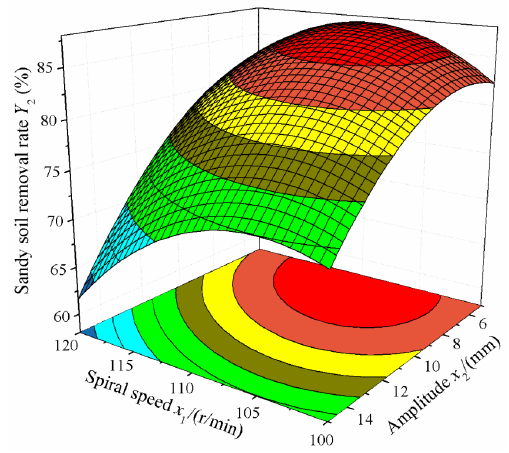
Figure 14. Influence of factor interaction on sandy soil removal rate.